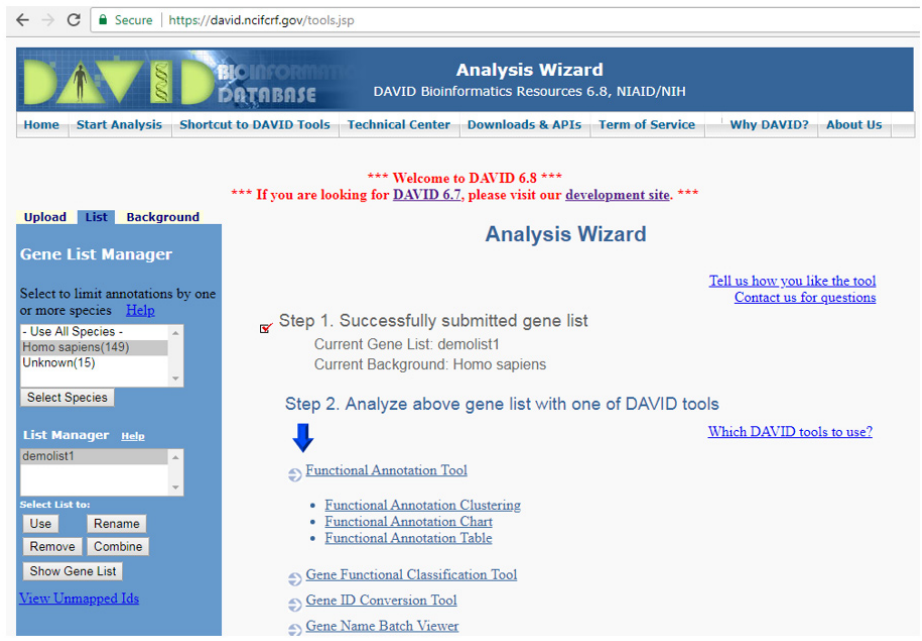
Figure 4. Species selection. Screenshot of a successfully submitted gene set. Here it is necessary to select the species. Again, note that in this instance for the sample genesets provided by DAVID, “Homo sapiens” is already highlighted along with the number of genes that are recognized by the site and for which information is available. Once the species is highlighted, it is necessary to click the “Select Species” button in order to limit the output to just the desired